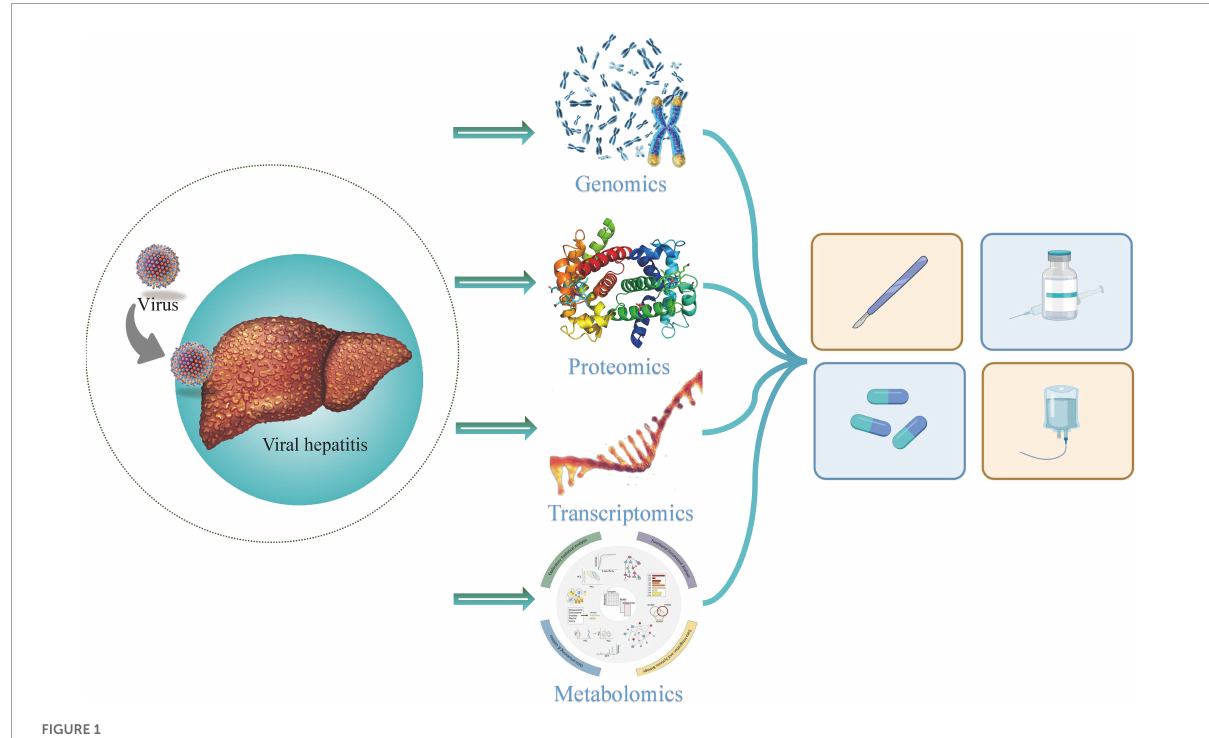
FIGURE1 Multi-omics in viral